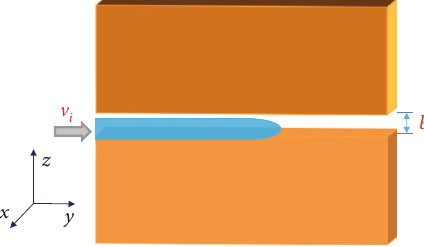
Figure 4: Sketch of grouting fl ow in coal